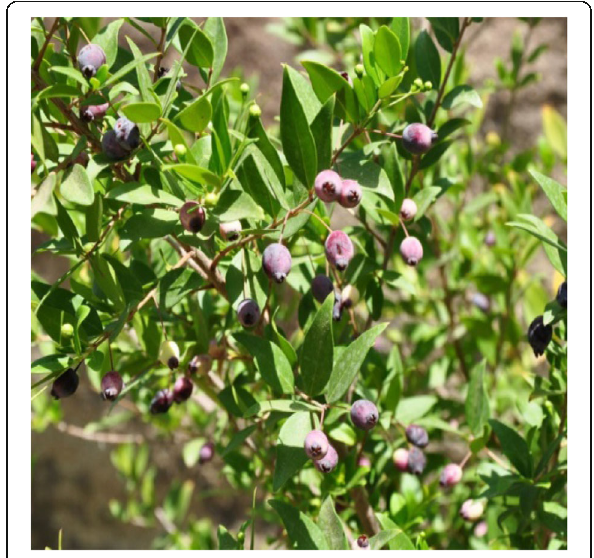
Fig. 9 Myrtus communis . This endangered non endemic, rare species belongs to the plant family Myrtaceae (Copy source Jacob Thomas Pandalayil)